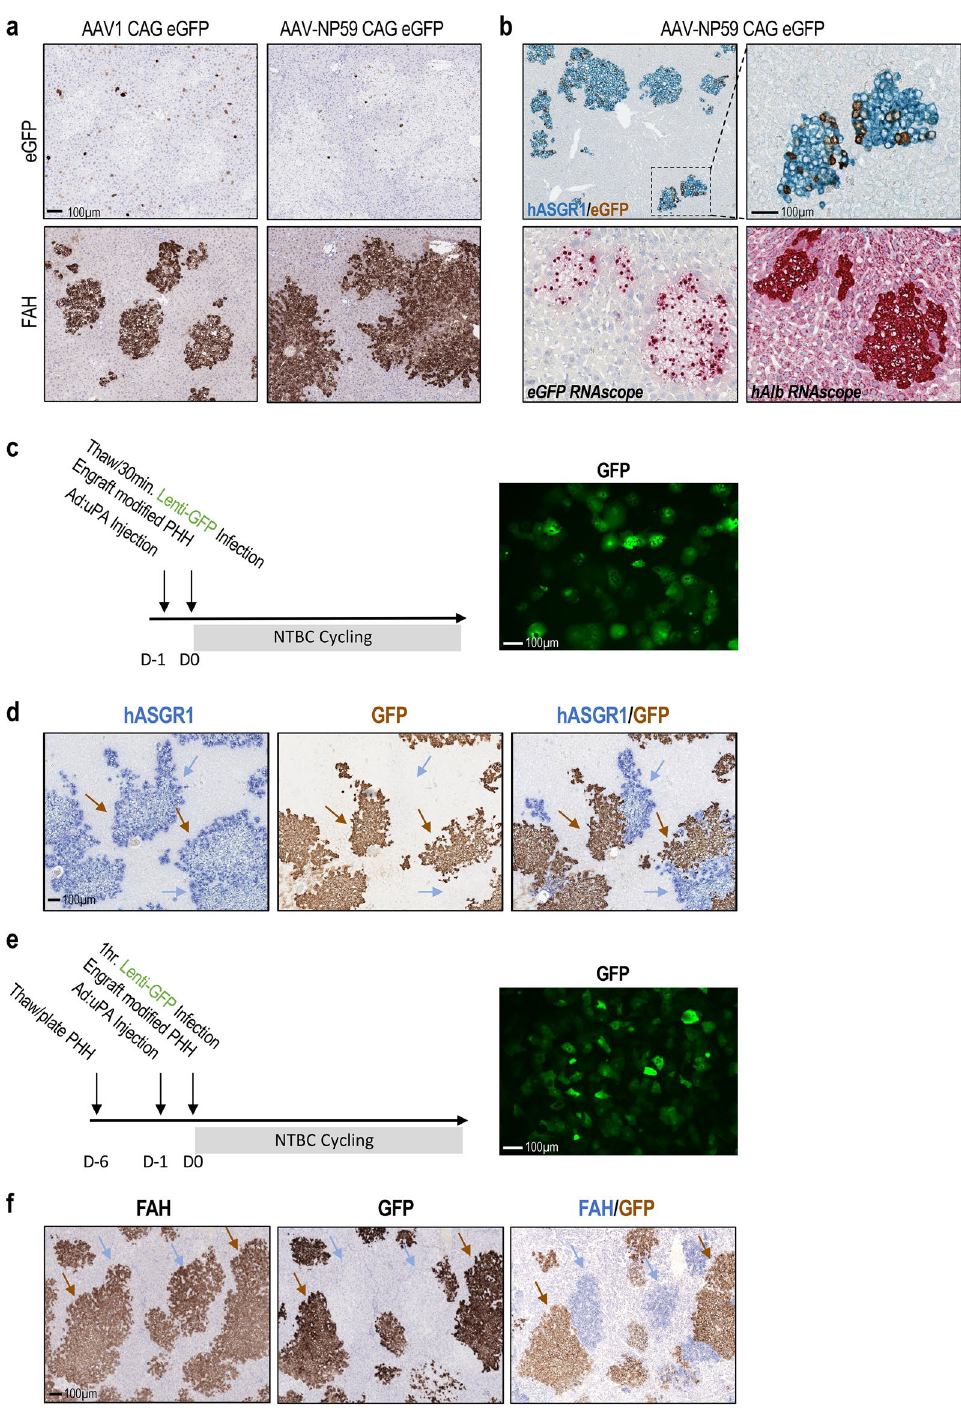
Figure 4. Human-hepatocyte-specific gene delivery in humanized liver rats. ( a ) eGFP and FAH IHC show different staining patterns after AAV1 or AAV-NP59 mediated eGFP delivery to humanized livers. ( b ) AAV-NP59 shows preference for human hepatocytes, confirmed by double IHC for hASGR1 (blue) and eGFP (brown) in top panels, and eGFP or human albumin RNAscope (bottom panels). ( c ) Experiment timeline and pre-engraftment GFP expression in human hepatocytes (donor FCL) transduced with Lenti-GFP for 30 min at 5.00E + 04 viral genomes (VG)/cell in suspension. ( d ) hASGR1 and GFP single or double IHC in rat livers engrafted with lentivirus-infected, freshly-thawed human hepatocytes. ( e ) Pre-engraftment GFP expression in human hepatocytes (donor FCL) after 6 days in culture and a 1-hr infection with Lenti-GFP at 5.00E + 04 VG/ cell. ( f ) FAH and GFP IHC staining confirms engraftment of lentivirus infected, cultured hepatocytes. Brown arrows point to GFP + human hepatocytes. Blue arrows mark GFP − human